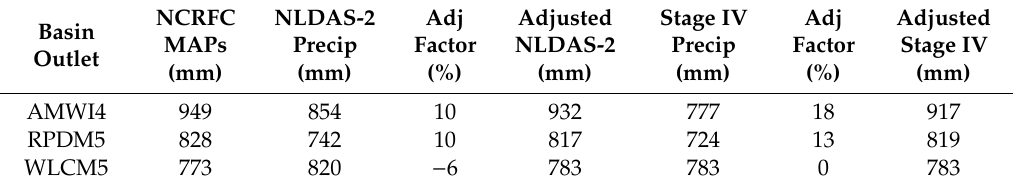
Table 4. Average annual precipitation totals (mm) for 2002–2013 period from the North Central River Forecast Center (NCRFC) mean areal precipitation (MAP) data, NLDAS-2, and Stage IV; precipitation adjustment factors (Adj Factor) for NLDAS-2 and Stage IV; and average annual precipitation for NLDAS-2 and Stage IV after the adjustment factor was